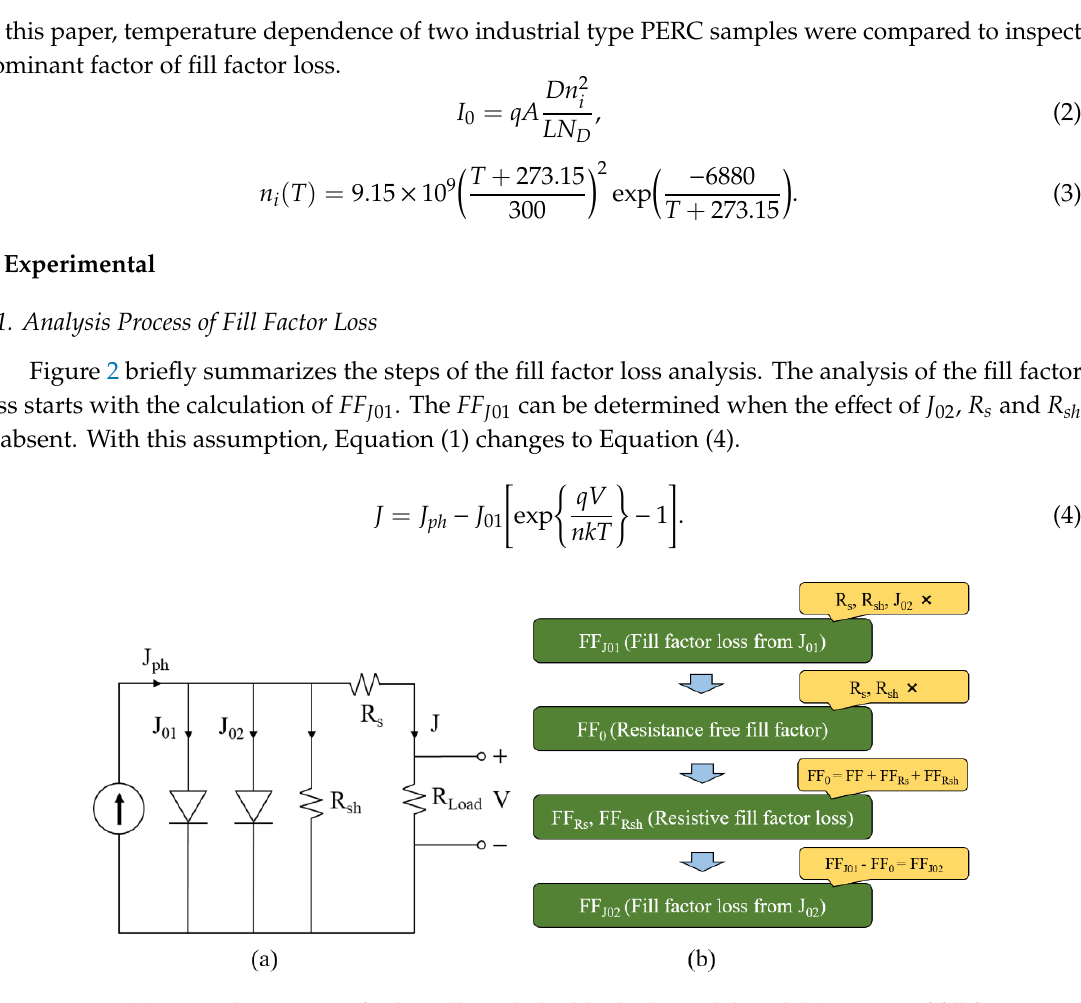
Figure 3. Schematic of the industrial PERC solar cell structure. 3. Results and Discussion 3.1. Temperature Dependence The two PERC solar cell samples were named by the PERC A and B. As a result of the illuminated J-V measurements (Table 1), V oc and fill factor of PERC B were 17 mV and 1.93 % higher at 25 °C, respectively. J sc difference was not significant (~1.3 mA/cm 2 ) and it comes from the different fraction of front metal contact. Graphs in Figure 4 show the drop of V oc and fill factor (depending on temperature), and also presents the average temperature coefficient as well. The average drop of V oc